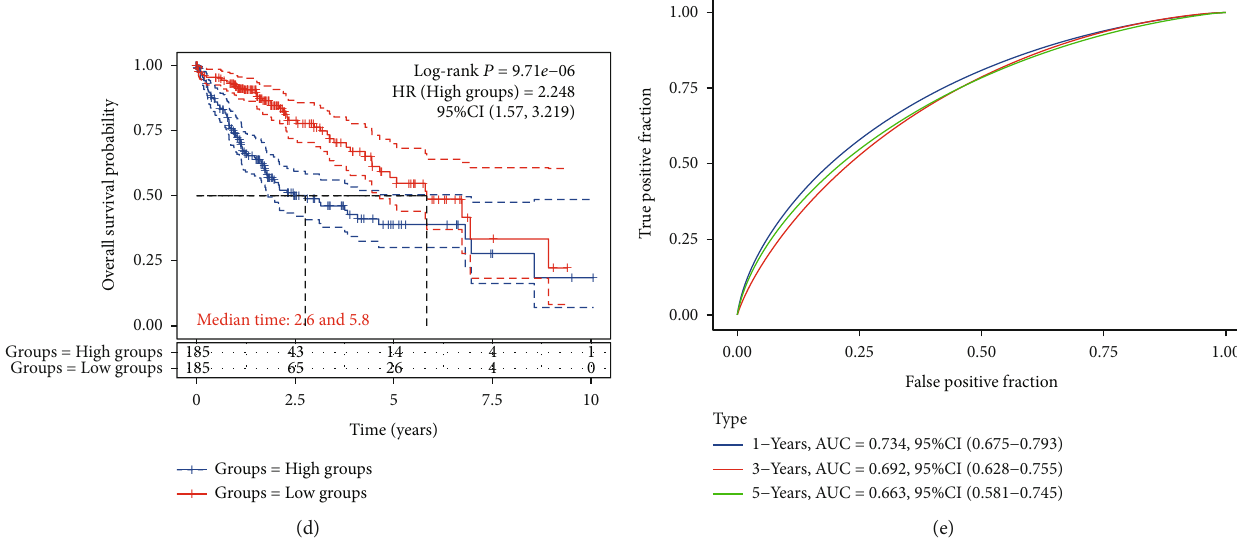
Figure 10: The construction of two gene signature and the assessment of its prognosis value. (a) LASSO coe ffi cient pro fi les of the three genes having a correlation with survival. (b) We drew a coe ffi cient pro fi le plot against the log (lambda) sequence in the LASSO model. (c) The distributions of the status, survival time, and risk score of patients from TCGA datasets. (d) Kaplan-Meier curves of the gene signature from TCGA datasets. (e) The prognosis gene signature ’ s time-dependent ROC curves from TCGA datasets.